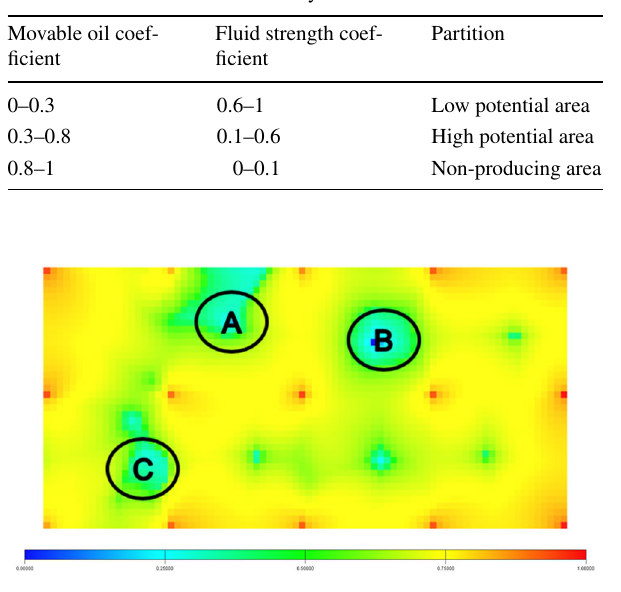
Fig. 3 Distribution of fluid intensity in high water cut